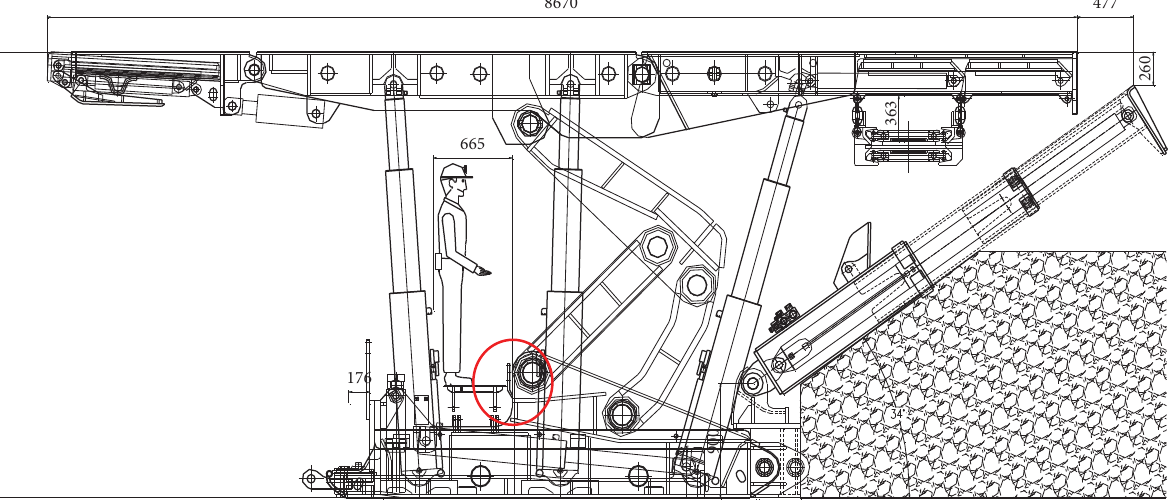
Figure 8: Optimized tamping machine.